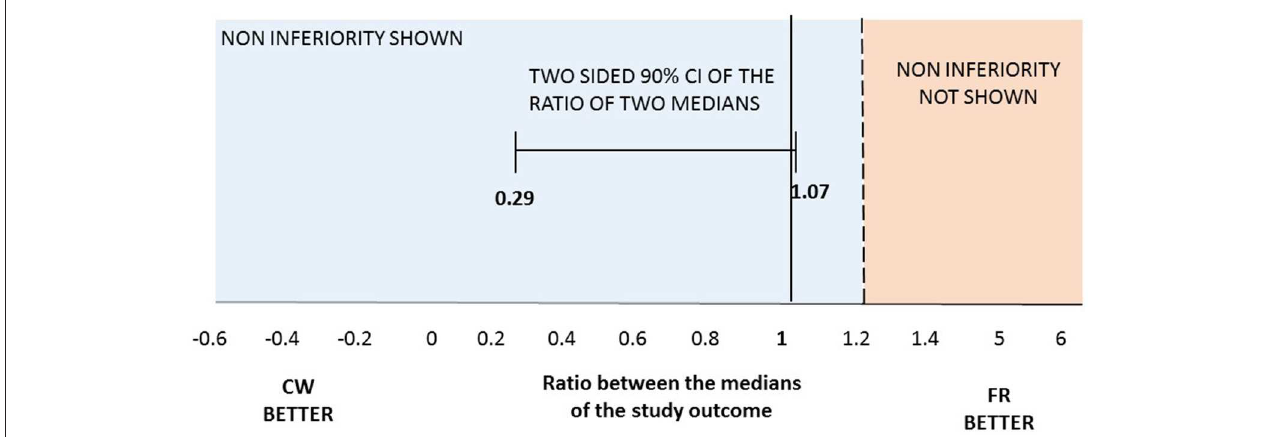
FIGURE 2 | Two-sided 90%CI for the ratio between median number of cumulative Gd-enhancing lesions at MRI observed in the two regimens. Maximum ratio of 1.2 lesions was set for the one-tailed test with a significance level of 0.05. At month 12 median of the cumulative number of Gd-enhancing lesions at MRI was 1 (0–9) in CW vs. 3 (0–10) in FR